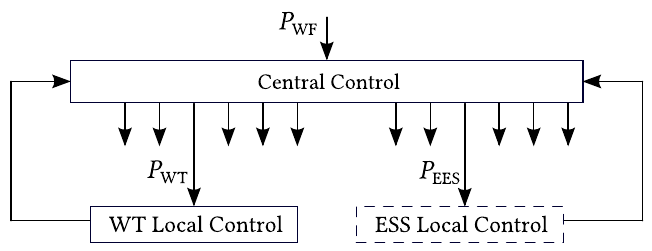
Figure 19. Control hierarchy at the wind farm